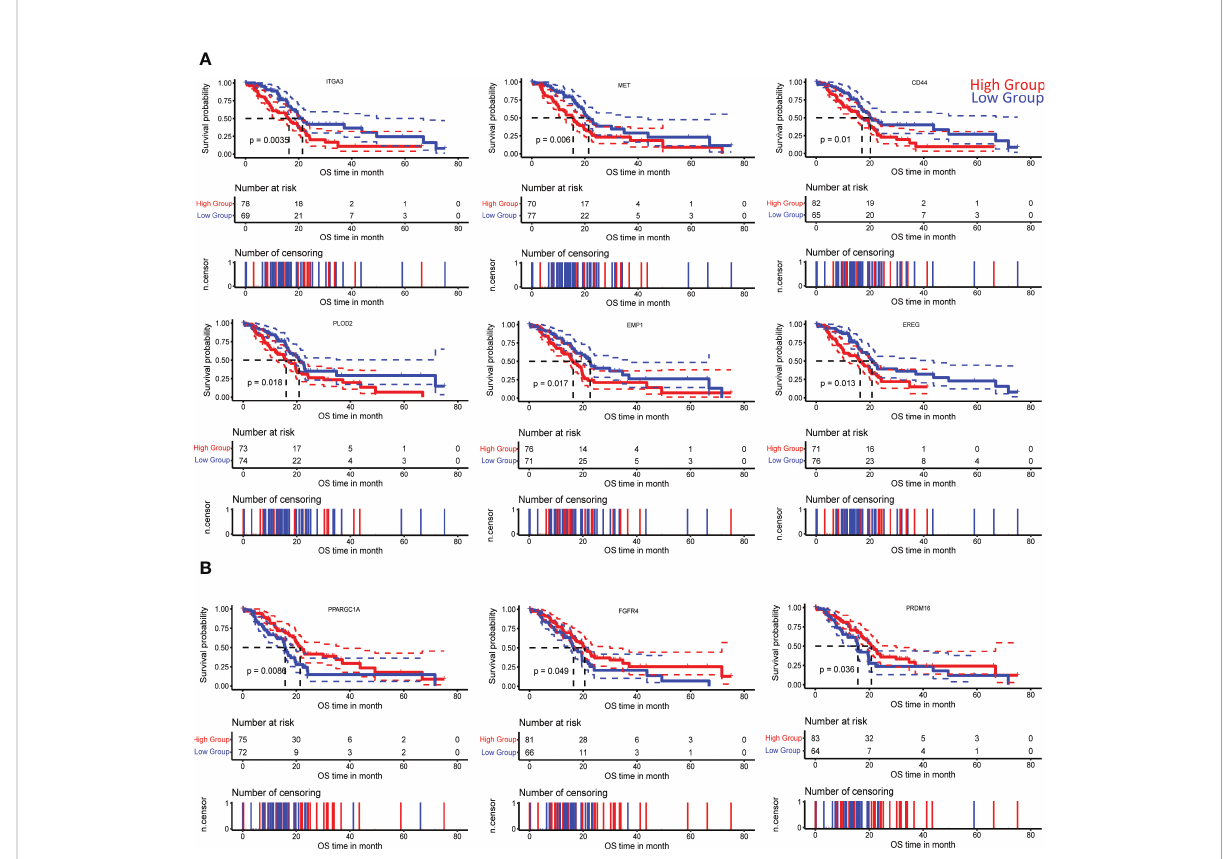
FIGURE 4 Correlation of PLAU-associated genes with survival in PDAC. Kaplan-Meier survival curves show that signi fi cantly worse overall survival of PDAC patients in the TCGA cohort is correlated with (A) increased expression of ITGA3 (log-rank test, P=0.0035), MET (log-rank test, P = 0.006), CD44 (log-rank test, P= 0.01), PLOD2 (log-rank test, P = 0.018), EMP1 (log-rank test, P = 0.017), EREG (log-rank test, P = 0.013) and (B) decreased expression of PPARGC1A (log-rank test, P = 0.0086), FGFR4 (log-rank test, P = 0.049), and PRDM16 (log-rank test, P =